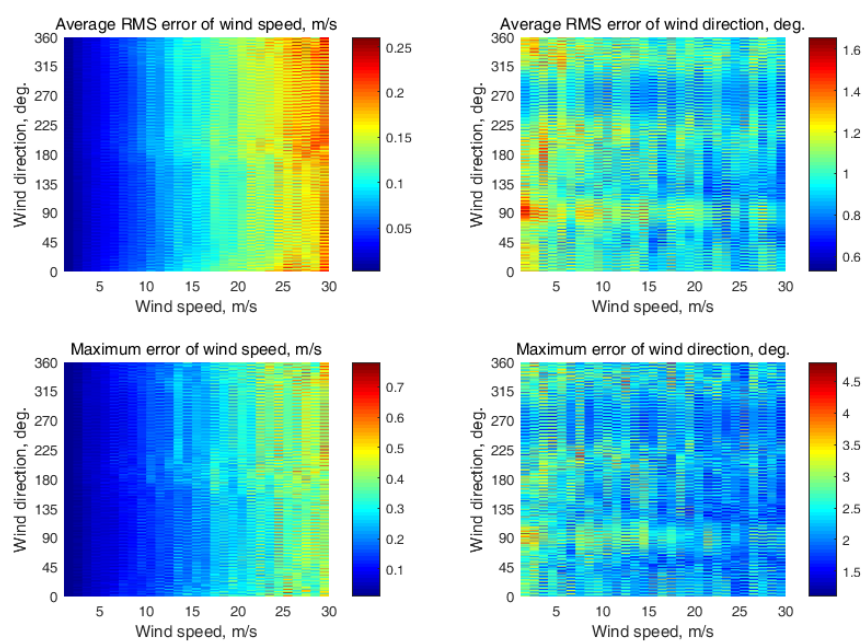
Figure A3. Semicircular wind retrieval results at a single 35° incidence angle.